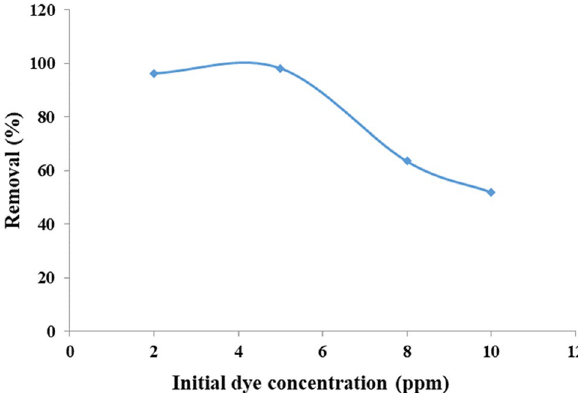
Figure 15. The effect of MB concentration using 0.005 g of